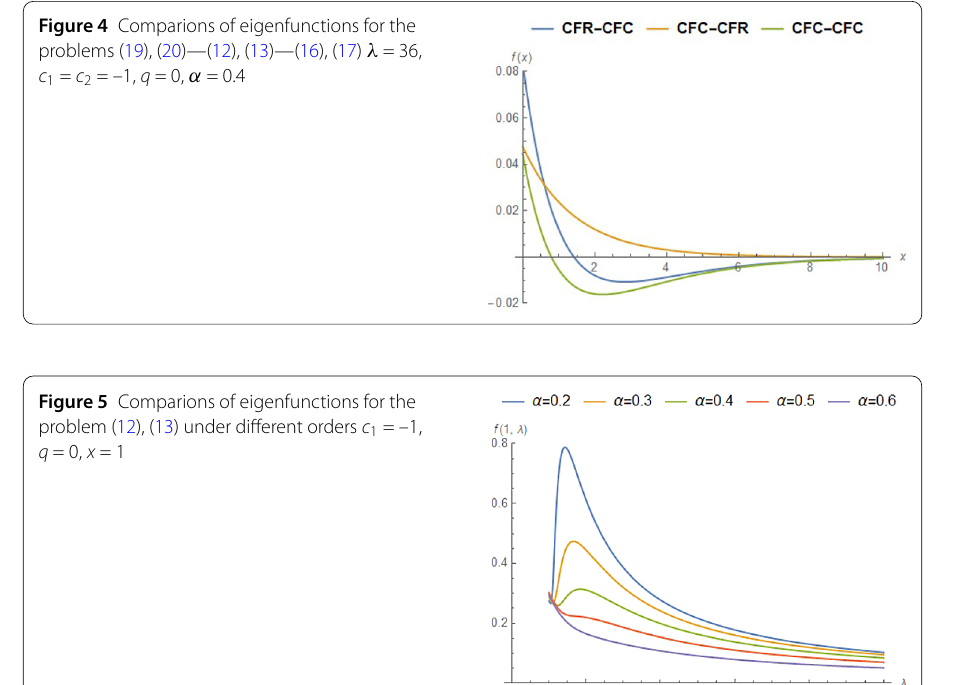
Figure 6 Comparions of eigenfunctions for the problem (12), (13) under different domains c 1 = –1, α = 0.4, q = 0